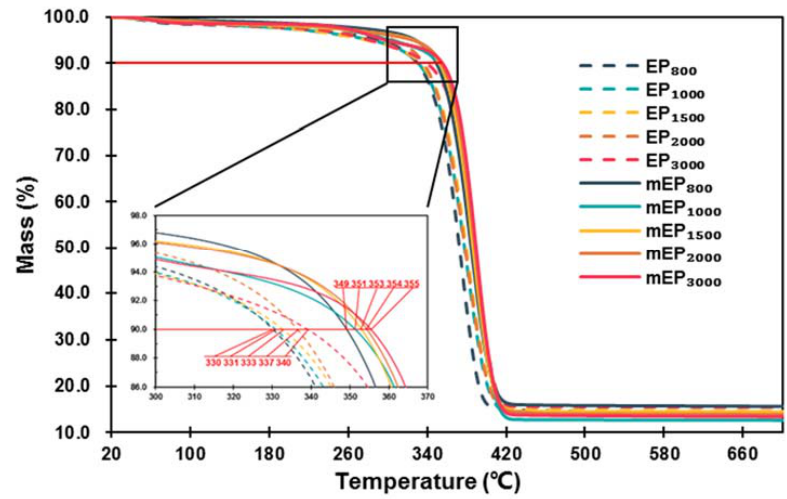
Figure 7. Thermogravimetric analyzer (TGA) curves of EPs and m ‐ EPs.